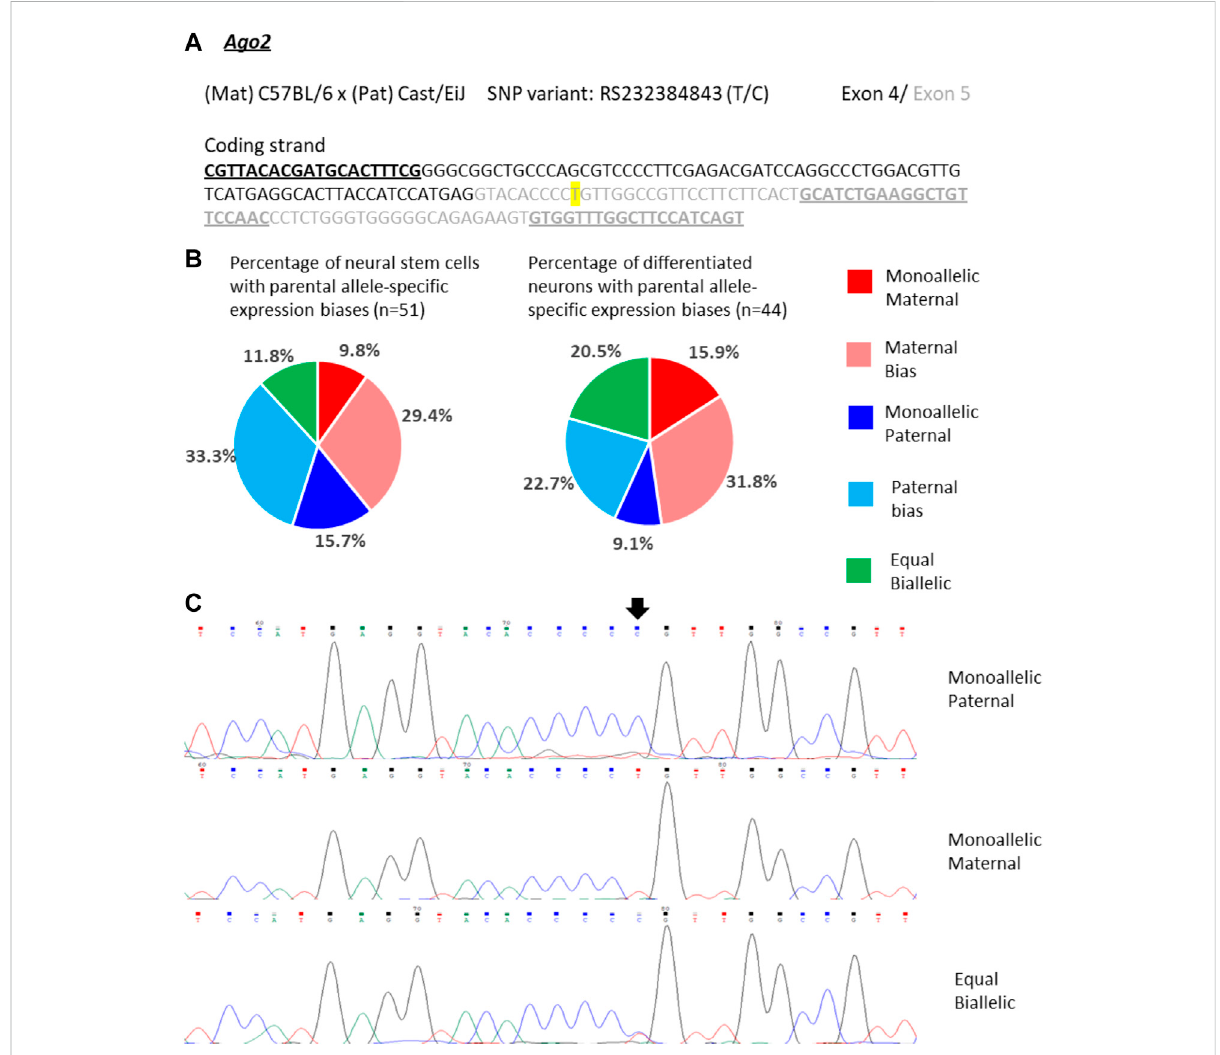
FIGURE 5 Variable single-cell allele-speci fi c expression of Ago2 analyzed through Sanger sequencing of a cDNA SNP from neural stem (neurosphere) cellsandtheir invitro differentiatedneurons. (A) Themousecross,cDNAampliconandSNPlocationinexon5areshown. B6SNPvariantisindicated in color; primers are underlined. (B) Summary data showing the proportions of cells falling into the fi ve categories of allelic expression. (C) Example single-cell sequence tracks for the three expression categories indicated. Sequence tracks for cells with maternal or paternal bias displayed a major SNP peak for those alleles with a minor overlapping SNP peak for the other allele, respectively. SNP position is highlighted by an